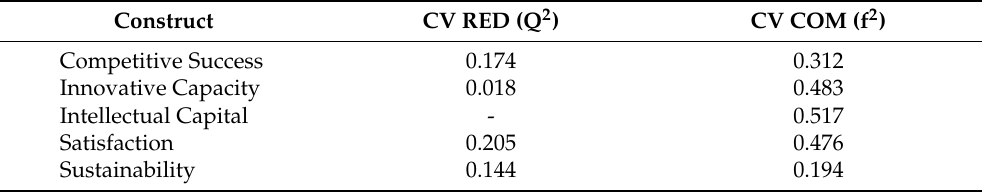
Table 5. Predictive validity (Q 2 ) or Stone-Geisser indicator, and effect Ssize (f 2 ) or Cohen indicator. Construct